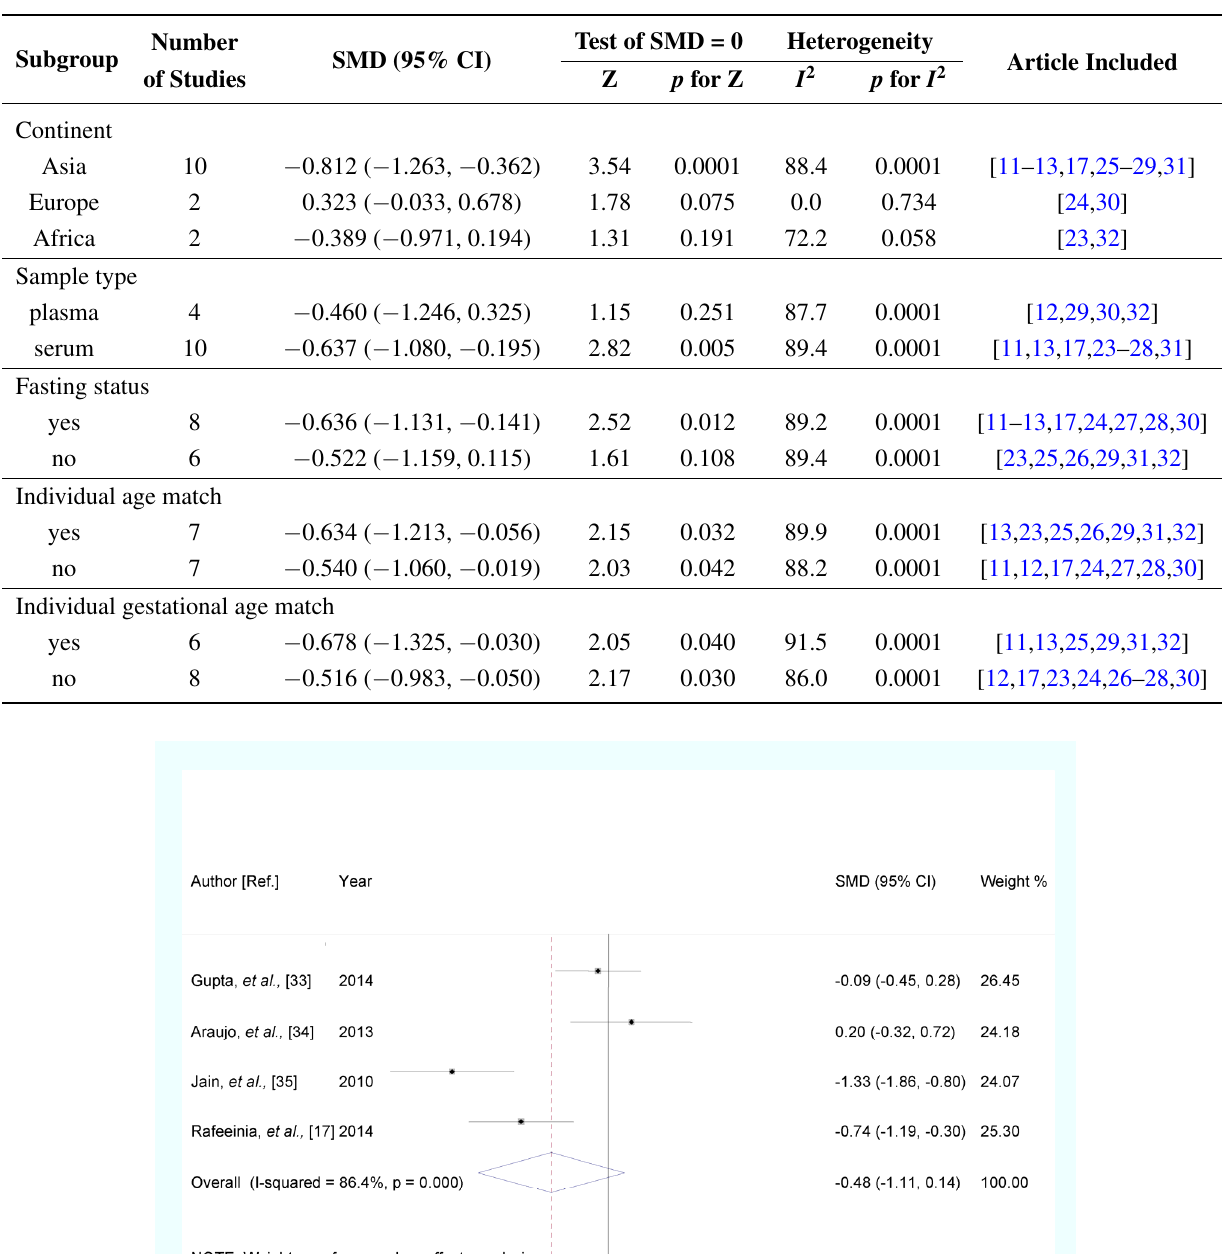
Table 2. Subgroup analyses of zinc level and preeclampsia (PE).